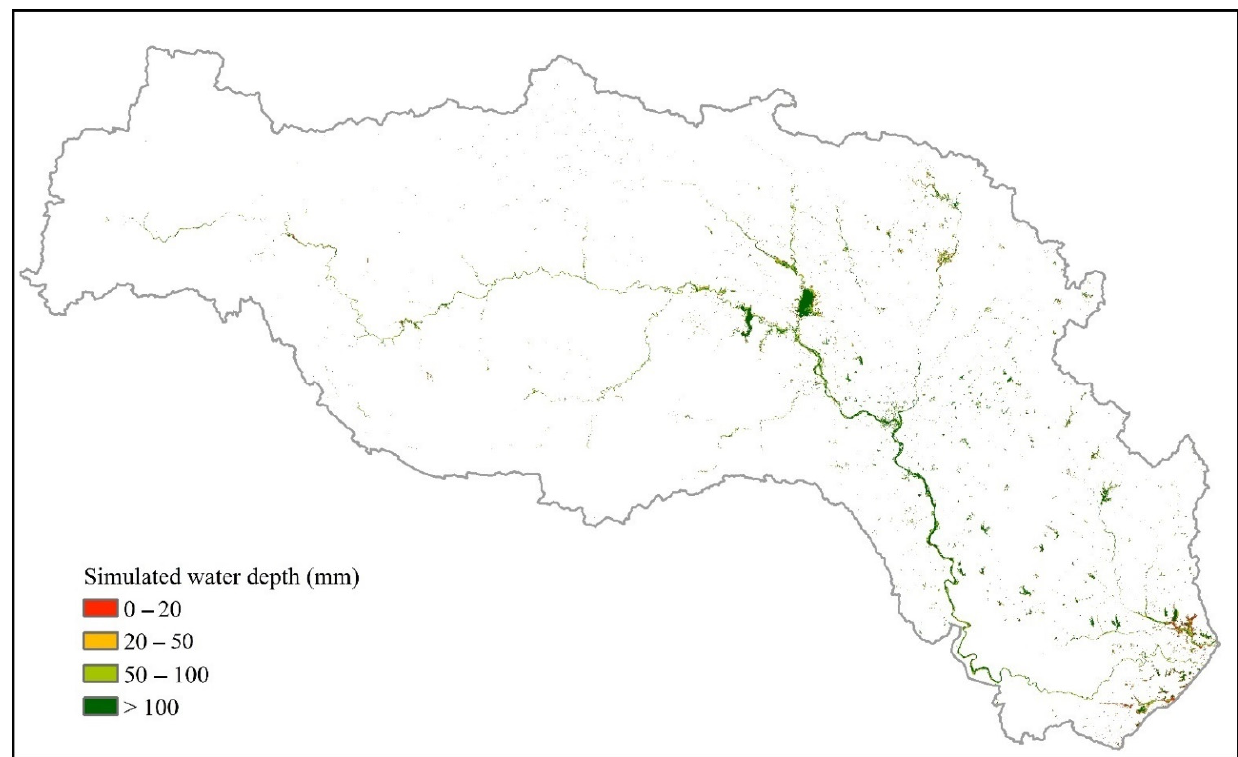
Figure 6. Comparing the modeled water surface area with HJ imagery.